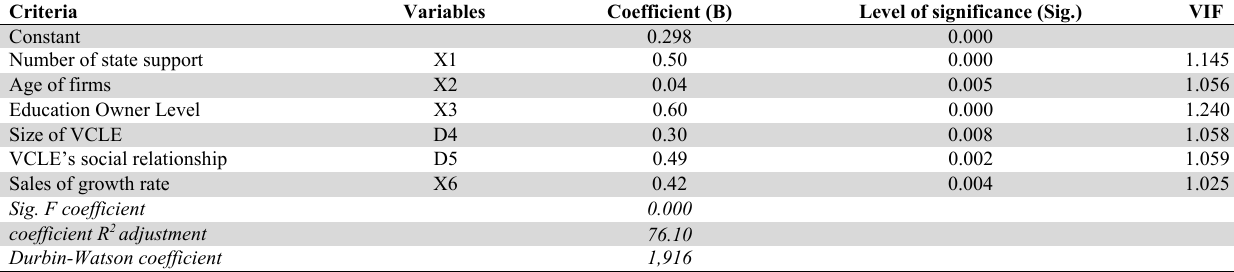
Results of the analysis model of linear regression